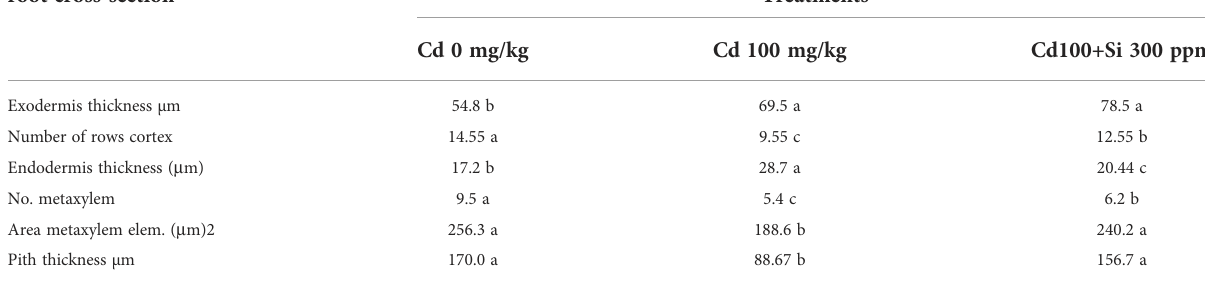
TABLE 6 Effect of foliar application of silicon on pea root cross-section grown in different concentrations of cadmium. root